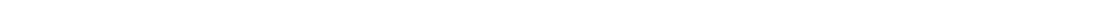
(see fi gure on previous page) Fig. 1 H 2 O 2 treatment forms a more abnormal nuclear shape in mitotic cells than in asynchronous cells. a Left panel: Asynchronous (upper) or mitotic (lower) HeLa cells were treated with 100 μ M H 2 O 2 for 10 h and subjected to immunocytochemical staining for Lamin B1 (green), α -tubulin (red) and DAPI (blue). Scale bar: 20 μ m. Right panel: Asynchronous or mitotic cells were treated with H 2 O 2 at the indicated concentrations, and the percentage of cells with abnormal nuclear shapes was measured after 10 h or 24 h. The results are shown as the means ± SDs of three independent experiments ( n = 300). *; Control versus H 2 O 2 , # ; Asynchronous versus Mitosis. * P < 0.05; ** , ## P < 0.01; ### P < 0.001 by Student ’ s t -test. b Representative examples of abnormal nuclear shapes in H 2 O 2 -treated cells. Upper panel; Lamin B1 staining (green). Lower panel: Images in the upper panels were converted to 2.5-dimensional images by using the ZEISS Microscope software ZEN. Scale bar: 5 μ m. c Electron microscopy images of the nuclear envelope in cells treated with or without H 2 O 2 for 10 h. Scale bar: 2.5 μ m. d The intensity of every pixel inside an imaginary circle drawn inside a nucleus was measured, and the standard deviation of the intensities of the pixels in a single nucleus was calculated by using ZEN software. We used the same samples as in (a). The results are shown as the means ± SDs ( n = 50). *; Control versus H 2 O 2 , # ; Asynchronous versus Mitosis. # P < 0.05; **, ## P < 0.01; ### P < 0.001 by Student ’ s t -test. e Nuclear circularity was calculated by using ImageJ software with the same samples as in ( a ). The results are shown as the means ± SDs ( n = 30). *; Control versus H 2 O 2 , # ; Asynchronous versus Mitosis. # P < 0.05; **, ## P < 0.01; ### P < 0.001 by Student ’ s t